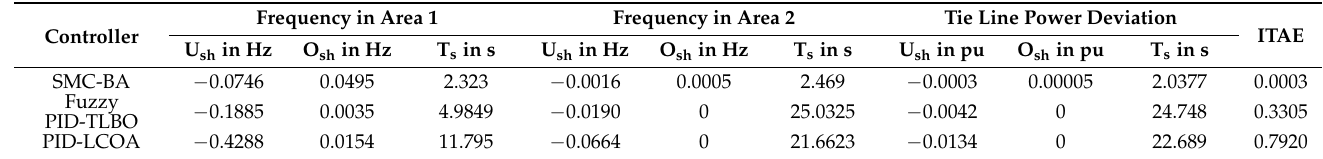
Table 5. Frequency response performances with different